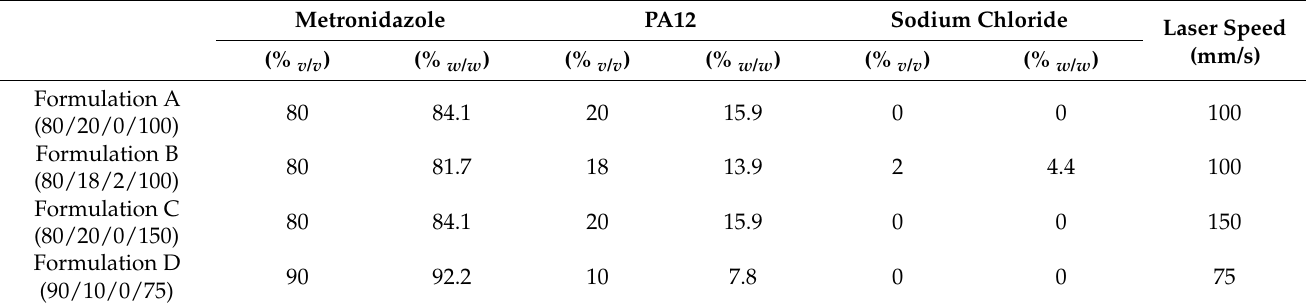
Table 1. Compositions expressed as volumetric ( v/v ) and weight ( w/w ) percent of components in printlets formulations and laser speed parameters. Metronidazole PA12 Sodium Chloride